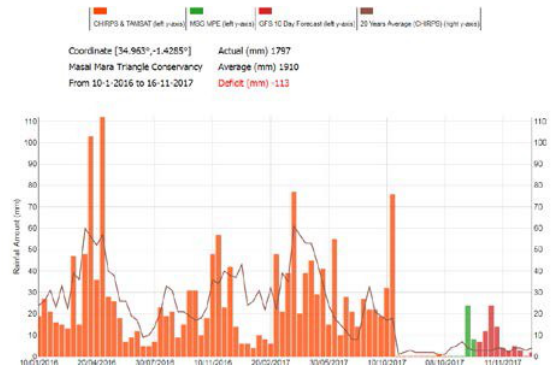
Figure 4. The perennial grass cover map 1DM production (gr/m2) = Rainfall (mm) * Grass cover (%) * Rainfall effectivity factor. The workflow calculating the forage productivity, compiled in ILWIS 4, is presented in Figure 5.